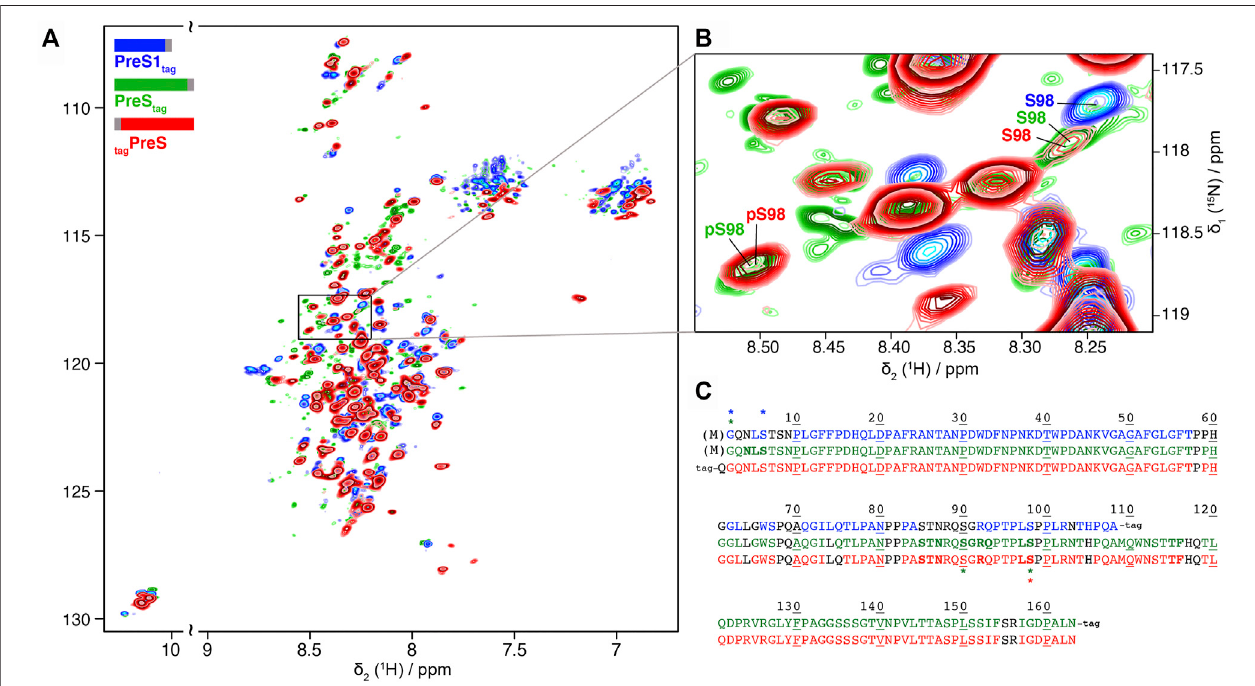
FIGURE3| PartialphosphorylationisdetectedbyNMRforPreSandPreS1producedusingcell-freesynthesis: (A) SolutionNMR 1 H- 15 NBEST-TROSYspectraof 2 H- 13 C- 15 NPreS1 tag atpH 7.5(in blue), PreS tag at pH6(in green) and tag PreSat pH6(in red). (B) Extract of2D BEST-TROSY spectrashowing apeak corresponding to unphosphorylated S98 for the 3 constructs on the top right. The peak is weak for both PreS tag and tag PreS, with another peak corresponding to phosphorylated S98 detectedatthebottomleft.ThismeansthatS98ismainly,butnotfullyphosphorylatedinPreS.TheC β chemicalshiftwasusedtocon fi rmthephosphorylationstate of this serine ( Supplementary Figure S10 ). (C) Sequence of the three constructs showing assigned residues for PreS1 tag (top, blue), PreS tag (middle, green) and α , C β and C ′ are assigned. tag PreS (bottom, red). Assigned residues are colored, while unassigned residues are in black type. Proline residues are colored when their C ResidueswhichdisplaytwoformsontheNMRspectraareshowninbold,andresidueswithchemical-shiftstypicalofphosphorylationandacetylationareindicatedbya star with the corresponding color-code. Processed residue M1 is shown in